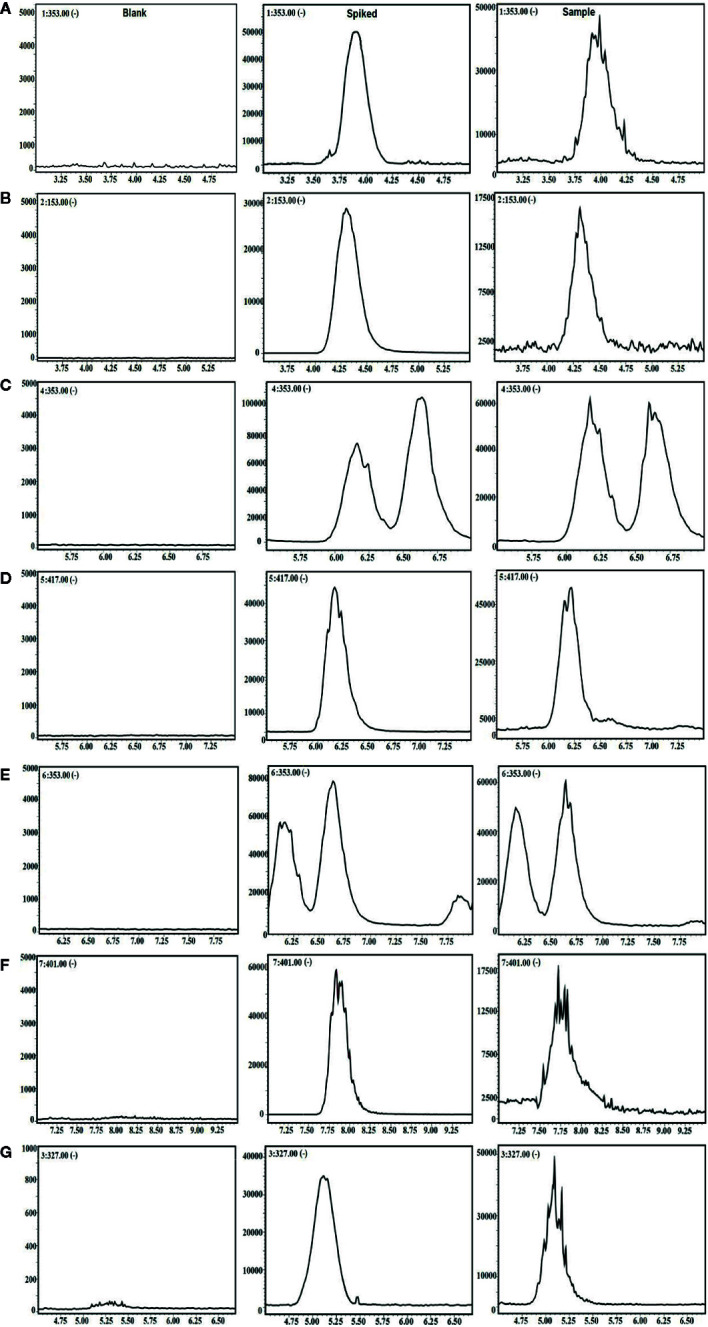
The selective ion monitoring (SIM) chromatograms of 6 compounds and internal standard (IS) in negative mode. (A) 5-CQA; (B) PCA; (C) 3-CQA; (D) EB; (E) 4-CQA; (F) GPS; and (G) IS.